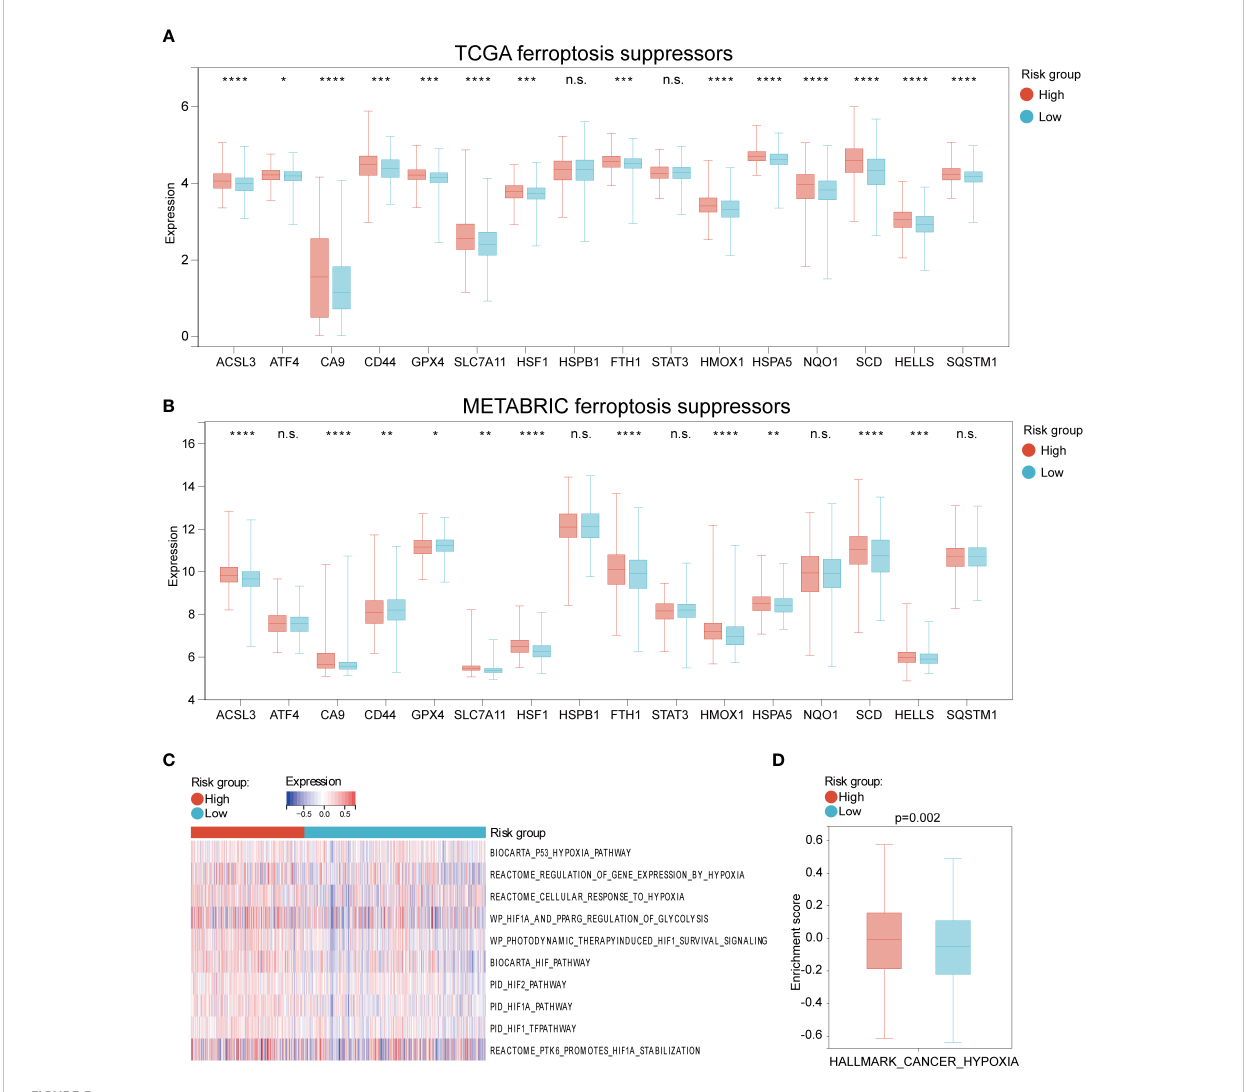
FIGURE 5 The different expression of ferroptosis and hypoxia regulations between high and low HFRS risk groups. (A, B) The boxplots shows the difference in ferroptosis suppressors mRNA expression between the high- and low-HFRS groups of the TCGA (A) and METABRIC (B) cohorts. (C) The heat map shows the association between Reactome hypoxia-related pathways and HFRS score in TCGA BC samples. (D) The boxplot shows the signi fi cant difference in the enrichment score of HALLMARK_CANCER_HYPOXIA between high- and low-HFRS risk groups. (*p< 0.05; **p< 0.01; ***p< 0.001; ****p< 0.0001, n.s., not signi fi